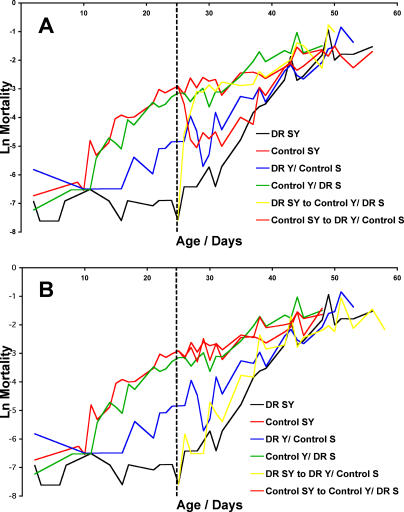
The Acute Effects on Age-Specific Mortality in Drosophila of Changes in Nutritional Content of the Food Midway through LifeVertical line represents switch day. Mortality trajectories were truncated when n < 40.(A) Switching between control and DR yeast (Y) diets midway though life results in rapid changes in age-specific mortality rates within 48 h similar to those seen previously for whole food dilutions [24]. Control yeast intake caused no irreversible damage since flies switched from control yeast to DR yeast at day 25 rapidly became no more likely to die than those flies given DR yeast levels throughout adulthood. Flies with a history of DR yeast levels showed rapid increases in mortality rate when moved to control yeast levels at day 25, but mortality rates did not become as high as those of flies that had been maintained on control yeast levels permanently.(B) Changing caloric intake to the same extent via changes to sugar (S) levels rather than yeast did not cause rapid changes in mortality rate. Despite flies chronically fed control sugar and DR yeast having increased mortality rate compared to the DR control, switching from DR to control sugar late in life did not increase mortality rate.